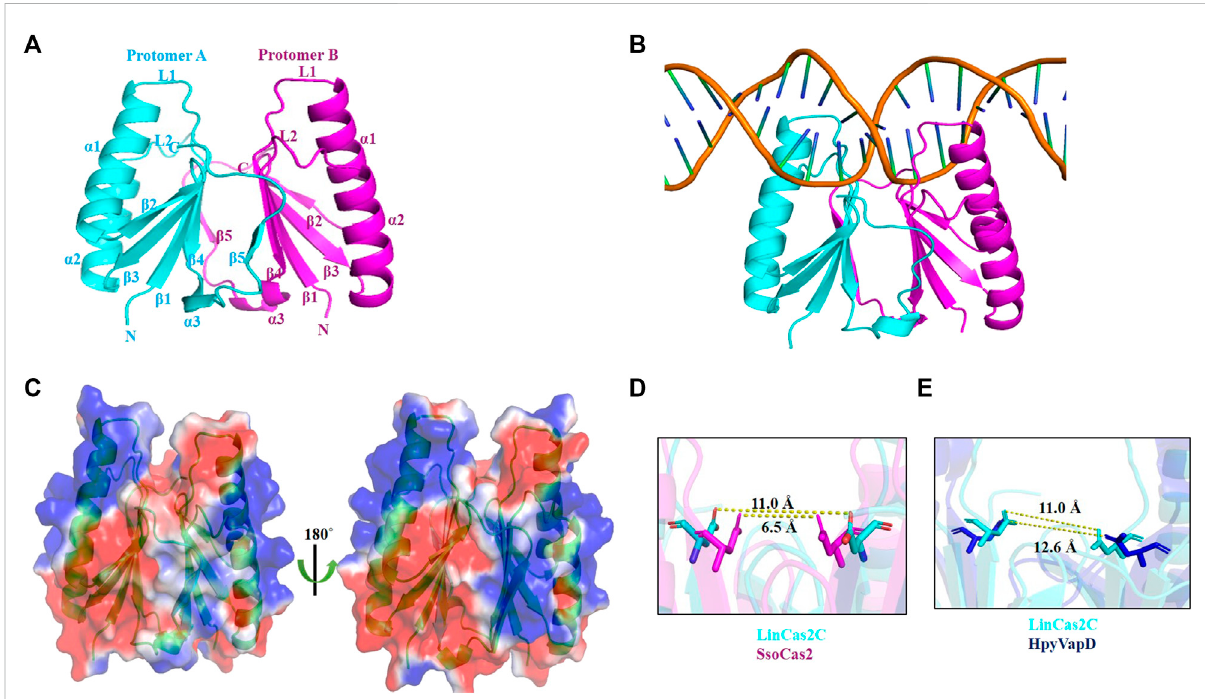
FIGURE 5 ThedimericinterfaceofrLinCas2Ccrystalstructure. (A) ThecrystalstructureshowsadimericformofrLinCas2C,whereoneprotomerisshown in cyan and another in magenta. (B) Putative DNA binding region on LinCas2C. LinCas2C bound DNA model using the template of Synechocystis Cas1-Cas2/prespacer binary complex structure (PDB id:7CR6). (C) Surface electrostatic potential map of LinCas2C. The positive and negative chargesareblueandred,respectively(scale-1 kcal/molto+1 kcal/molforredandblue,respectively). (D) Comparisonofthedistancebetween Asp residues side chain of the two protomers of LinCas2C and SsoCas2 and (E)